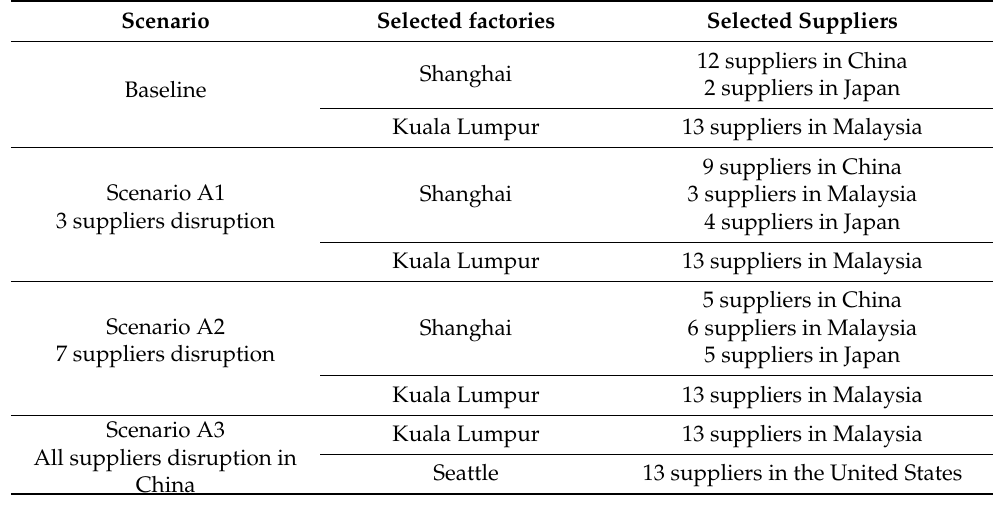
Table 5. The selection of suppliers and factories in scenario A.